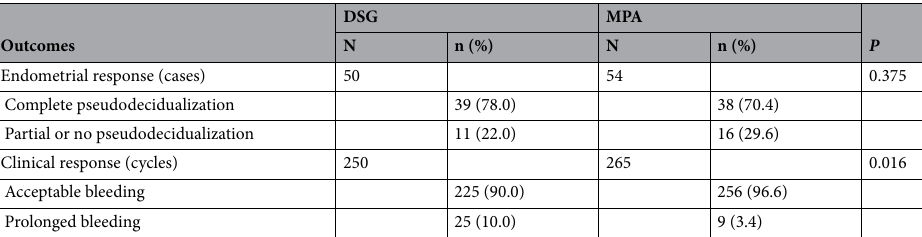
Table 2. Efficacy outcomes. The endometrial response rates were compared using chi-square test; whereas the clinical response rates were compared using generalized estimating equations (GEE). A P -value < 0.05 indicates statistical significance. For endometrial response, 95% CI of difference (Δ) in the proportion of complete pseudodecidualization is (− 9.1% to 24.4%); the lower bound of which lies above the non-inferiority limit of − 10% For clinical response, acceptable bleeding includes treatment cycles with normal withdrawal bleeding (amount and duration) and treatment cycles without withdrawal bleeding. DSG desogestrel, MPA medroxyprogesterone acetate.